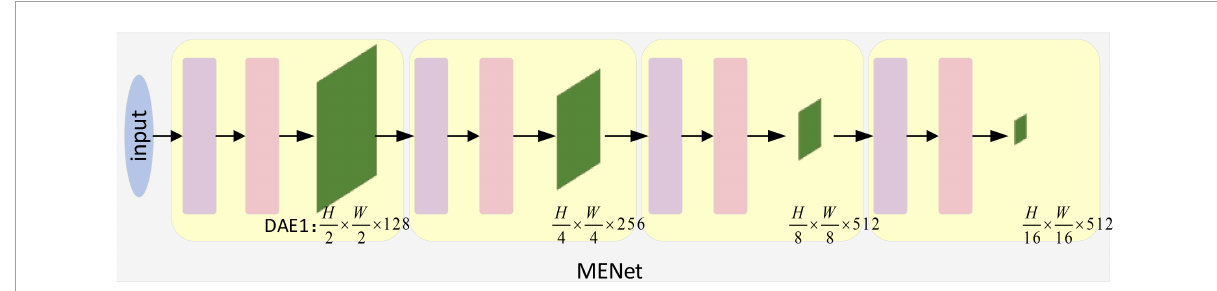
FIGURE3 Modulation enhancement network structure diagram. Inspired by the selective mechanism in V1, V2, and V4, we design the modulation enhanced network, which can better correspond with V1, V2, and V4 by combining with the coding network. H and W represent the size of the image and feature graph, respectively, and 3, 128, 256, 512 represent the number of channels, respectively. The down-sampling embedding (DE) and transformer_encoder (TE) modules are described in detail in Figure 4 .